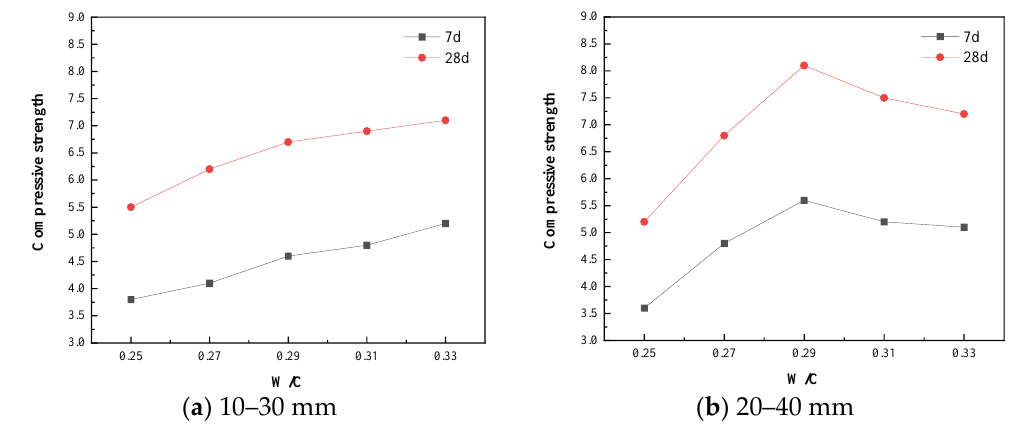
Figure 9. Relationship between compressive strength and water – cement ratio.